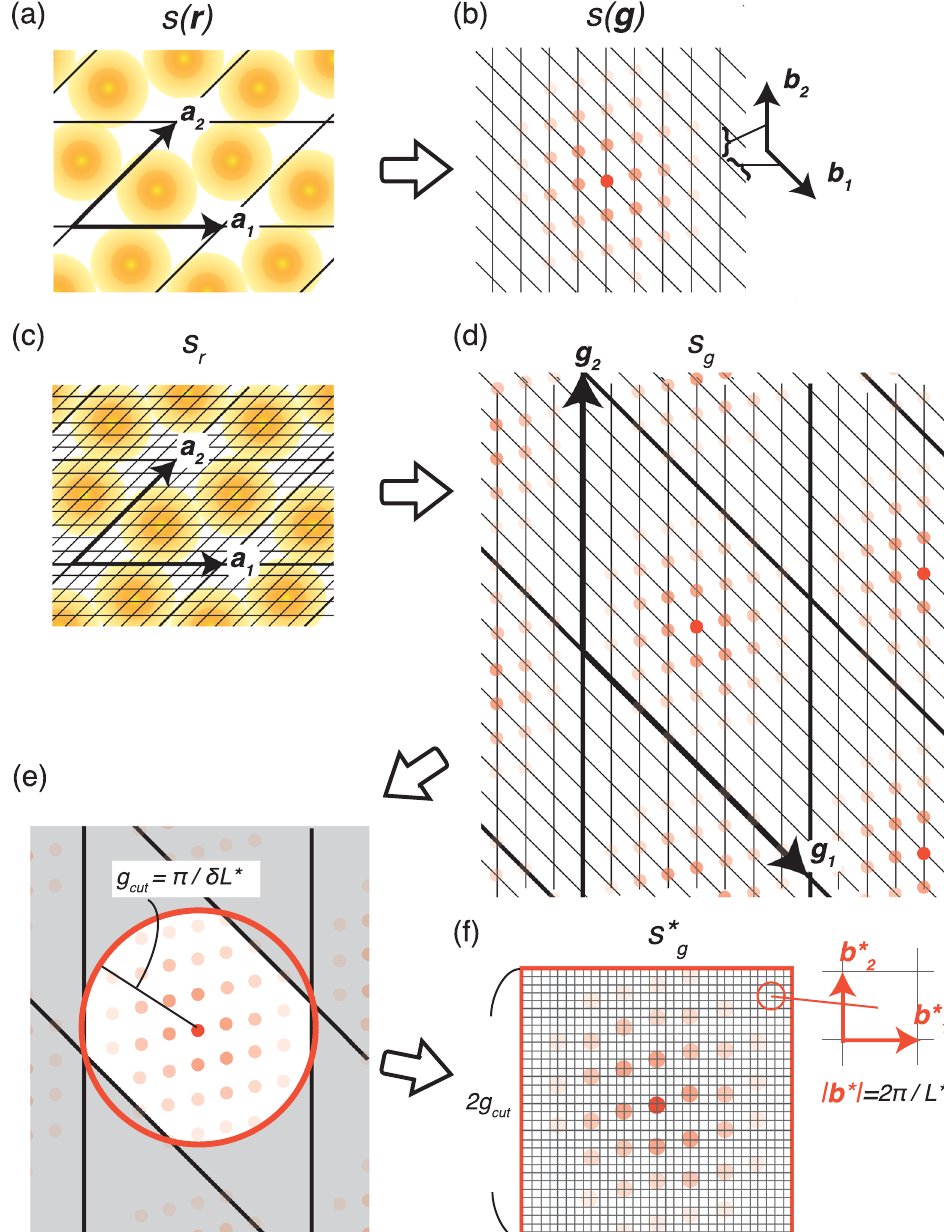
Figure 1. A schematic of the concept of the R3DVS descriptors. ( a ) A continuous, field quantity s ( r ) in a solid and ( b ) its Fourier coefficient s ( g ) in the reciprocal lattice space. ( c ) The discretised function s r and ( d ) the corresponding Fourier’s coefficients s g . ( e ) The s g values are hollowed out with a radius g cut from g = 0 origin, and ( d ) the voxel values are rearranged on a new cubic meshes, which are defined by parameters δ L * and L * (see the main